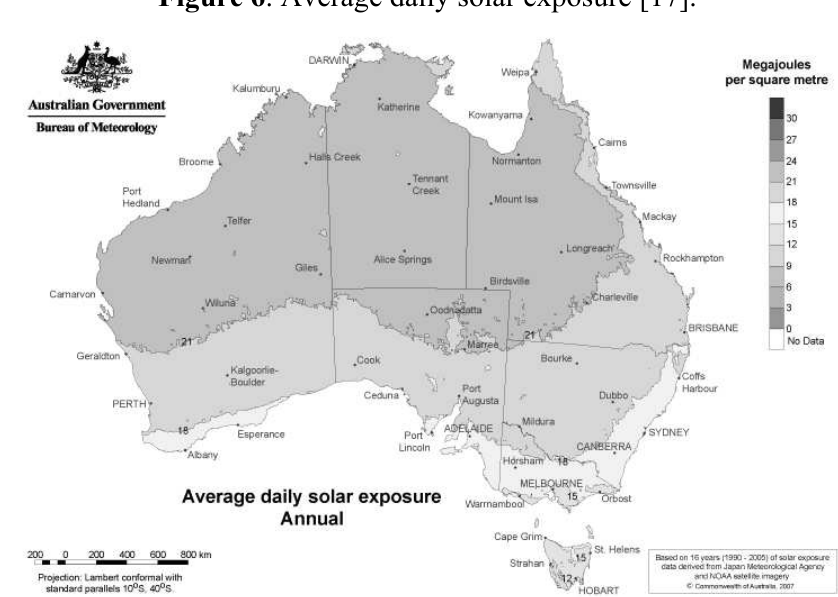
Figure 6 . Average daily solar exposure